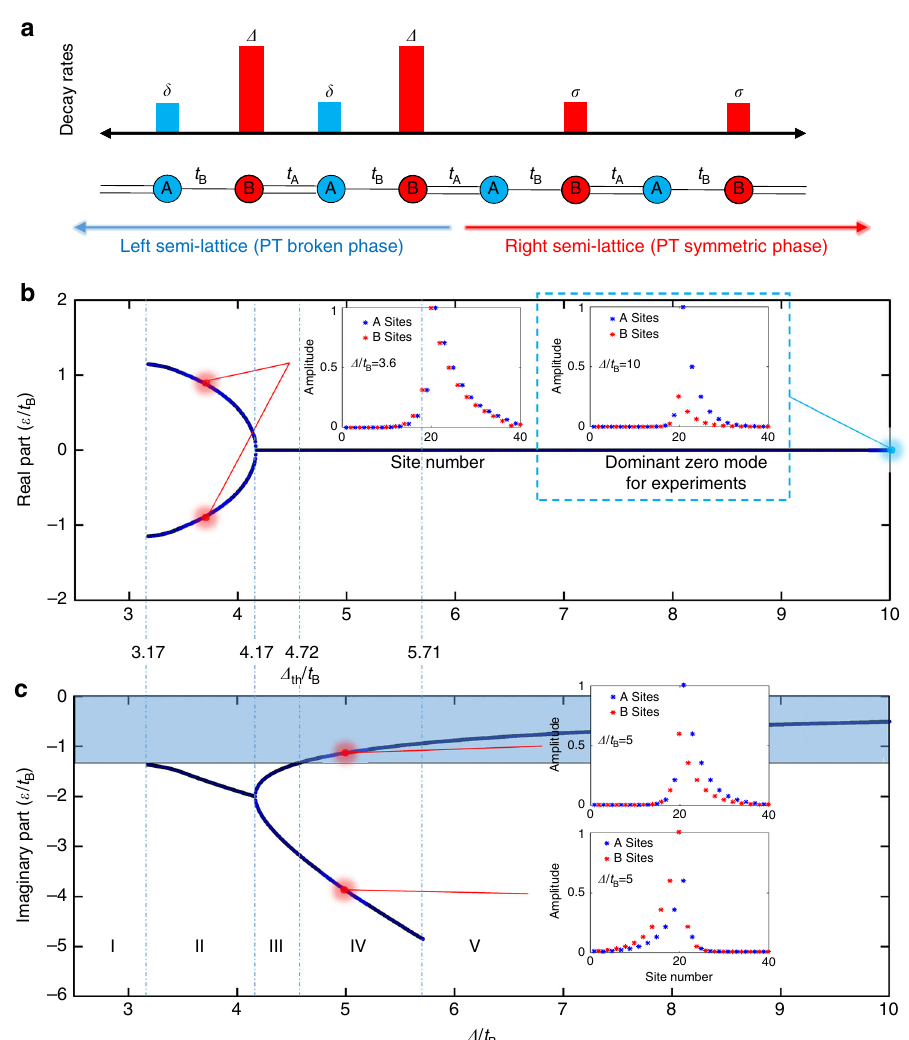
Fig. 1 Bifurcation diagram of the interface modes in a Su – Schrieffer – Heeger (SSH) lattice. a Schematic of an interface realized by two dissipative SSH semi- lattices, where A sites have higher decay rates ( Δ or σ ) and B sites are associated with lower decay rates ( δ or 0). Each semi-lattice is in the same topological order (i.e., we assume uniformly t A > t B ). b , c Bifurcation diagram of the interface states for t A / t B = 2.5 and σ = 2.5 t B , and for the right semi- array in the passive unbroken PT phase (Phase I: δ = 2.5 t B ). As Δ / t B is increased, fi ve distinct regions can be de fi ned: Region I ( Δ = t B (cid:3) 3.17), no interface states exist; Region II (3.17 ≤ Δ / t B ≤ 4.17), there are two interface modes with opposite real part of energy, the same decay rate (imaginary part) and the same intensity distributions; Region III (4.17 ≤ Δ / t B ≤ 4.72), there are two non-dominant zero-energy modes with different decay rates and intensity distribution; Region IV (4.72 ≤ Δ / t B ≤ 5.71), one of the two zero-energy modes becomes dominant in the system; Region V (5.71 ≤ Δ / t B ), there is only one dominant interface state, the other one becomes an unbound state whose fi eld extends to the whole left lattice. The value of Δ / t B that separates regions III and IV is the threshold value Δ th / t B required to observe a dominant zero-energy mode in the dynamics. Note that for Δ = t B > δ = t B þ 2 ð 1 þ t A = t B Þ = 9.5, the left semi-array is in the fully broken passive PT phase (phase III), i.e., the interface of phase I and phase III semi-arrays can create a dominate zero-energy interface mode. The insets show a few distributions of mode amplitudes of interface states at a few values of Δ / t B . We did experiments on Δ / t B = 10, circled by blue box in the picture. The colored area in c shows the region where an interface mode becomes dominant (i.e., lowest decay rate as compared to extended Bloch